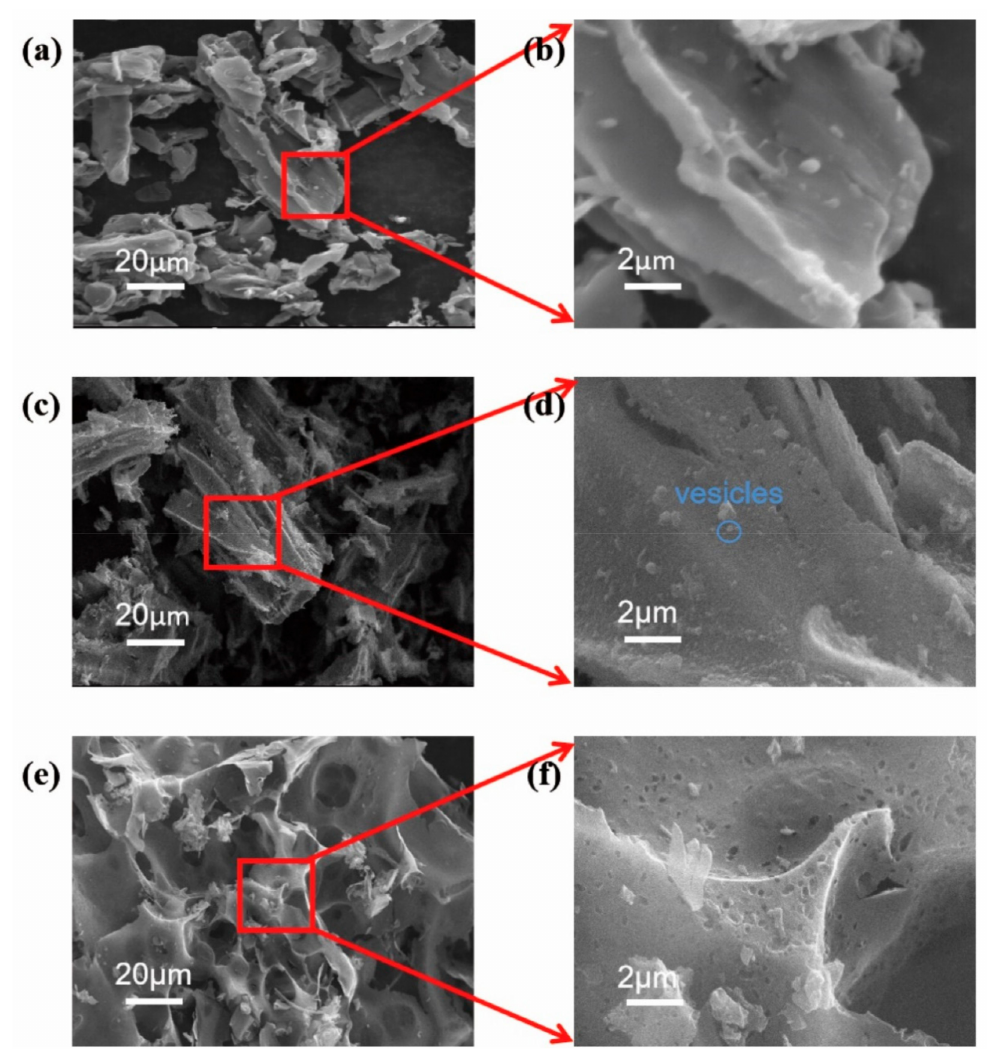
Figure 2. Field-emission scanning electron microscopy (FESEM) images of ( a , b ) Blank-TC, ( c , d )TC-0 and ( e , f ) TC-1 samples at various